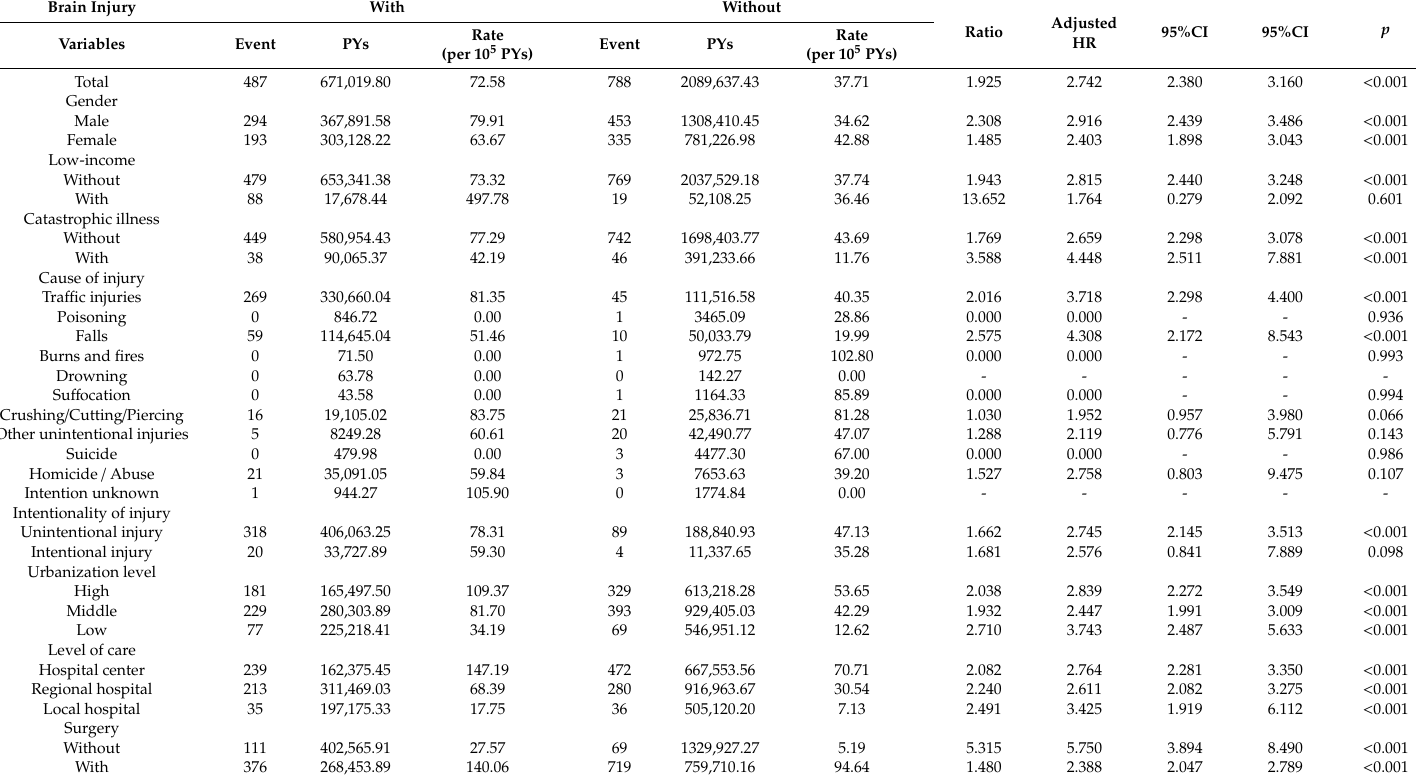
Table 3. Cholesteatoma of middle ear and mastoid in the end of follow-up stratified by variables listed in the table by using Cox regression. Brain